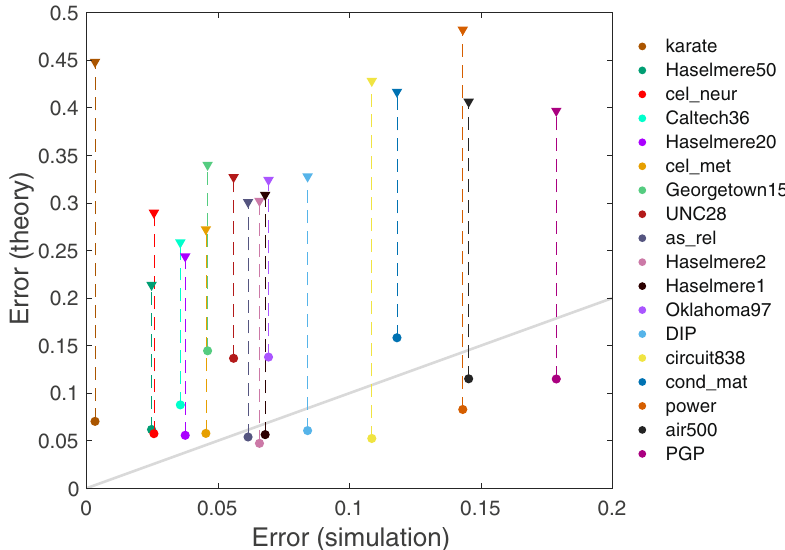
Fig. 4 Comparison of susceptible – infected – susceptible with ambient infections (SISa) error with estimate and theoretical bound for benchmark real- world networks. Comparison of the absolute value of the mean error computed via simulations on the horizonatal axis with and our theoretically derived approximation (circular markers) and bound (triangular marker) on the vertical axis for a selection of benchmark real-world